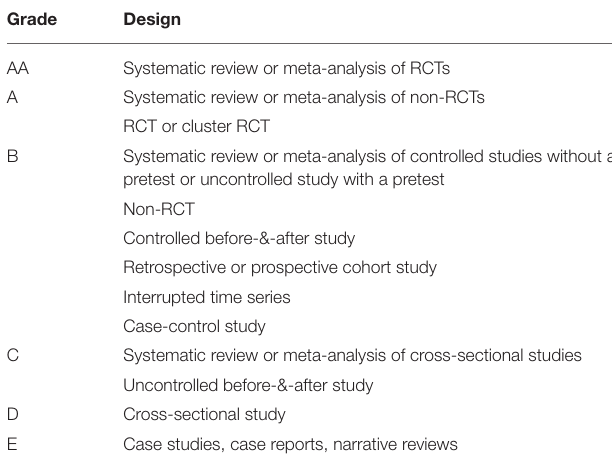
TABLE 1 | Grading of study design quality